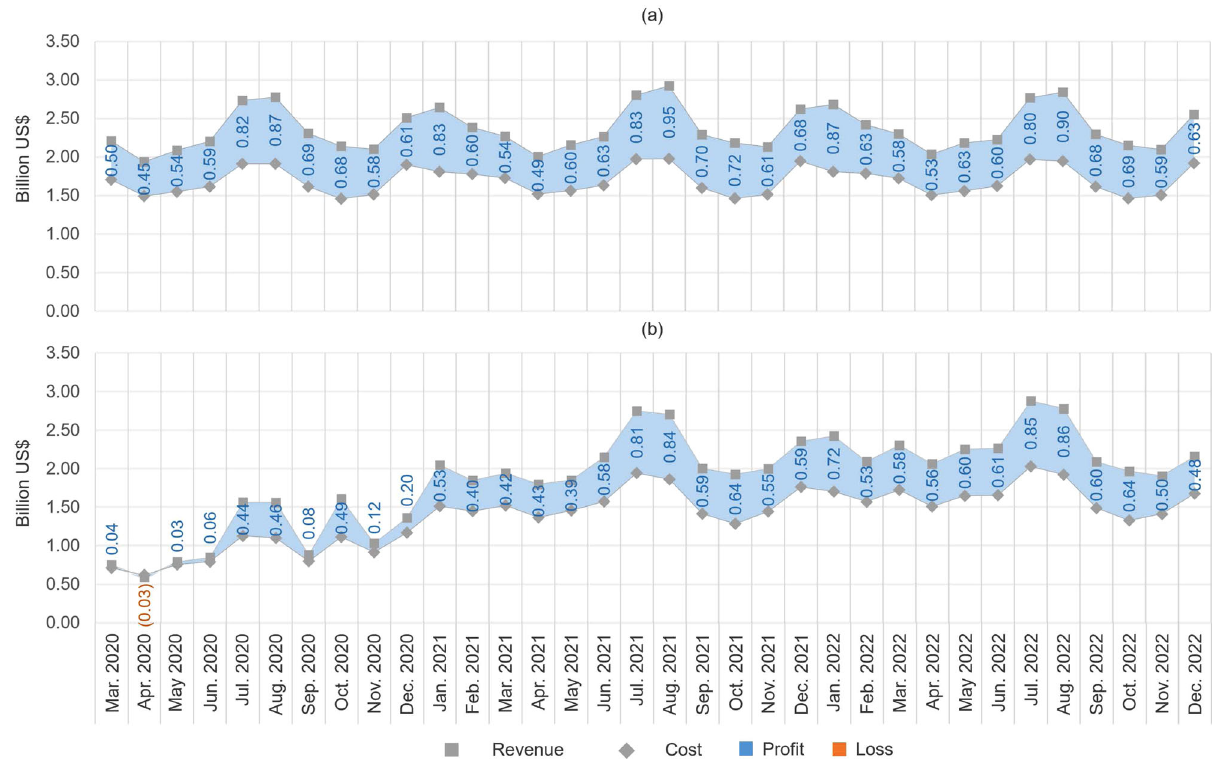
Fig. 4 Monthly coal generator revenues, costs, and pro fi ts, March 2020 through December 2022. Monthly revenues, costs, and pro fi ts for all coal plants in aggregate are shown in the counterfactual scenario in which COVID-19 had not occurred (panel a) and the current expectations scenario (panel b). Squares represent revenues, diamonds represent costs, and the shaded areas represent pro fi ts or